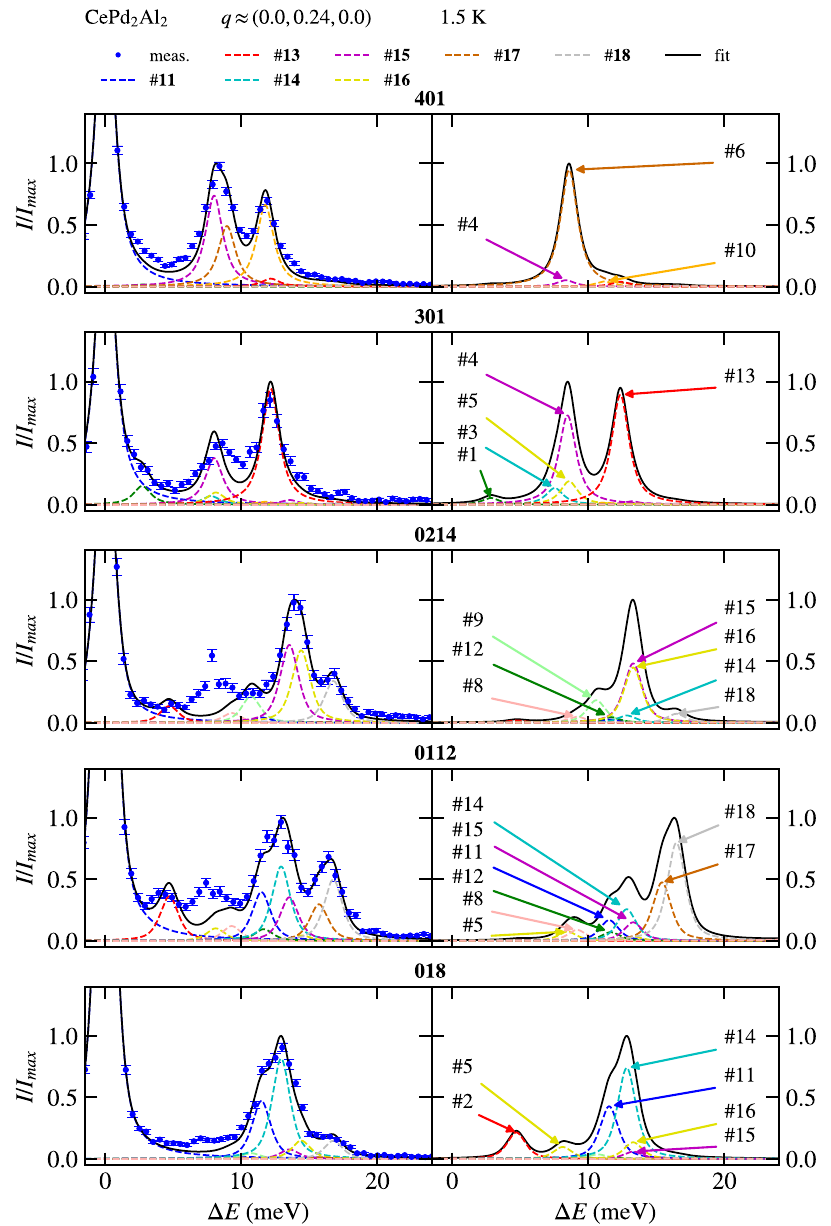
( 0.00, 0.24, 0.00 ) on the left and calculated intensity based on Figure 5. The fit of measured data at q = dynamical structure factor on the right. Each pair of graphs correspond to the given Brillouin zone specified in bold above them. The most intense modes are labelled. The colour of the selected mode is the same across the Brillouin zones. The legend above shows modes of which energies were possible to determine